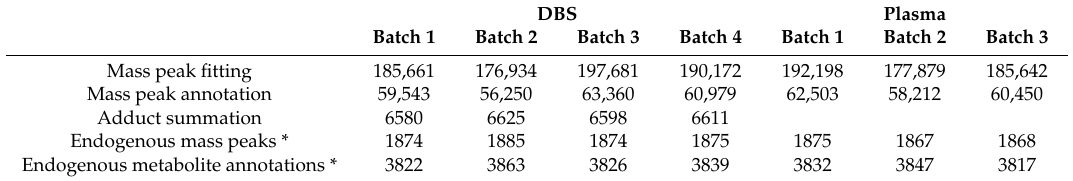
Figure 1. Flowchart of the non-quantitative direct-infusion high-resolution MS (DI-HRMS) method. DBS: dried blood spots, IEM: inborn error of metabolism, cs: control samples, ps: patient samples, DI-HRMS: direct infusion high resolution mass spectrometry, SD: standard deviation. Table 1. Variation in number of mass peaks and metabolite annotations in data processing steps.